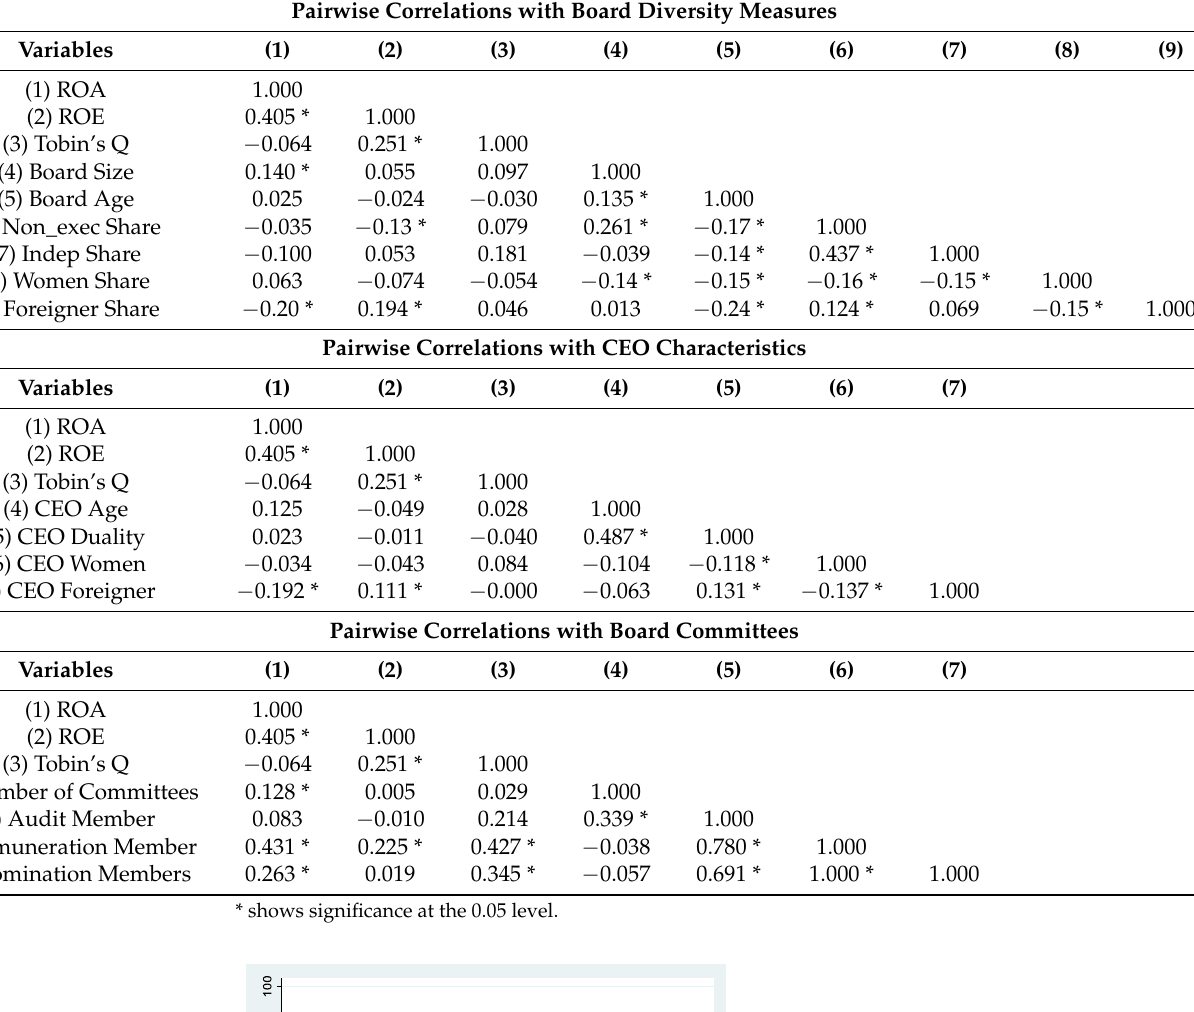
Table 3. Correlation coefficients of firm performance.